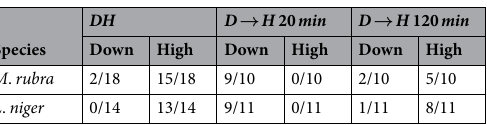
Table 1. Food source preference of each experiment for both species in DH and D → H conditions. Number of experiments with significant choices versus total number of experiments (binomial test with P < 0.05). In DH condition, both species strongly exploit preferentially the high food source. In D → H , while both species exploit the down food source until 20 min (as the high one is only available after 20 min (D → H 20 min )), at the end of experiment, respectively 5/10 ( M . rubra ) and 8/11 ( L . niger ) colonies preferentially exploit the high food source (D → H 120 min